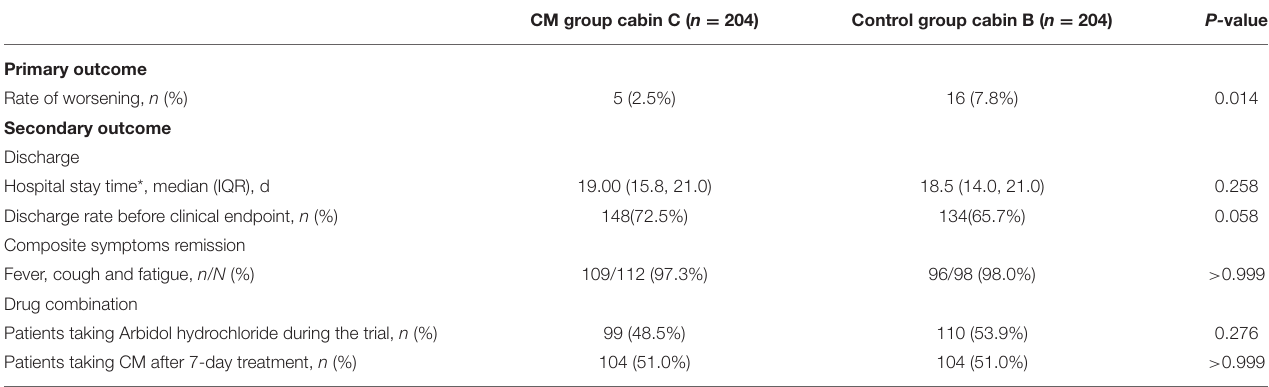
TABLE 3 | Primary and secondary outcome measurements during the